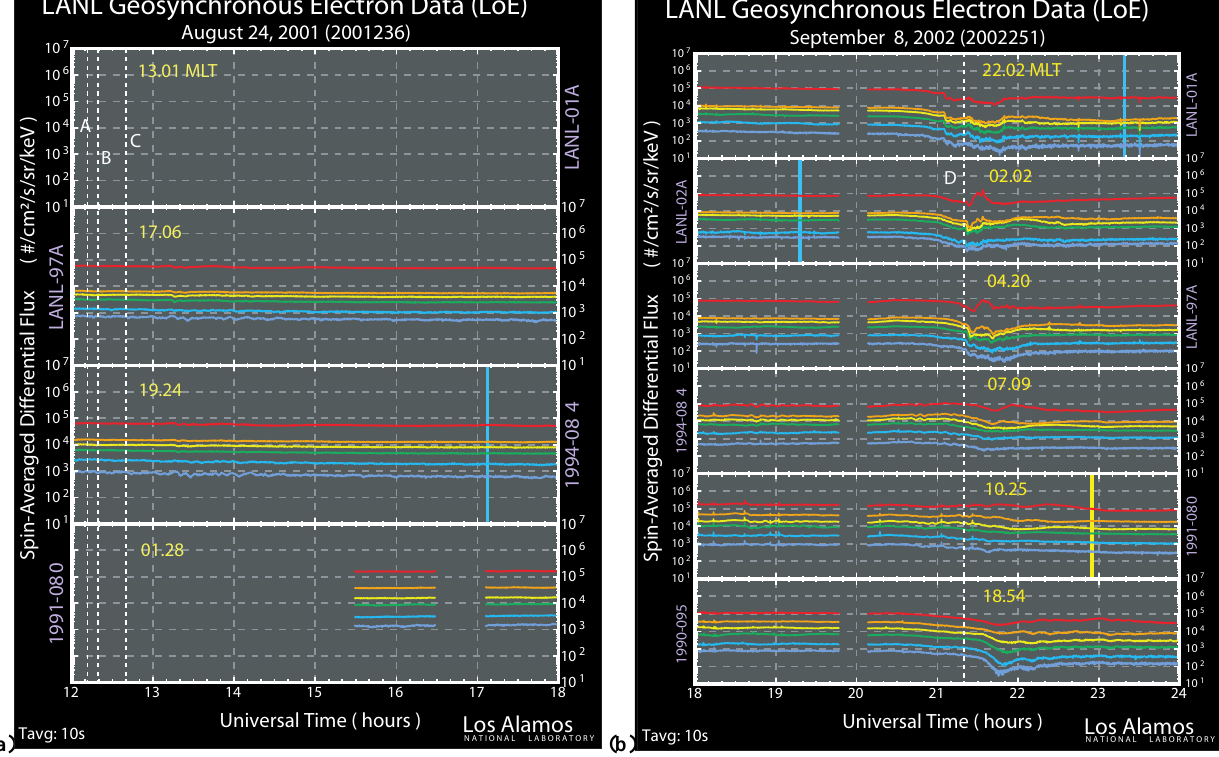
Fig. 7. Energetic electron data from several geosynchronous satellites (LANL) for (a) 24 August 2001 and (b) 8 September 2002. The vertical dashed lines mark the events A, B, C, and D. The yellow numbers indicate the magnetic local time (MLT) of the satellites at the time of the events C and